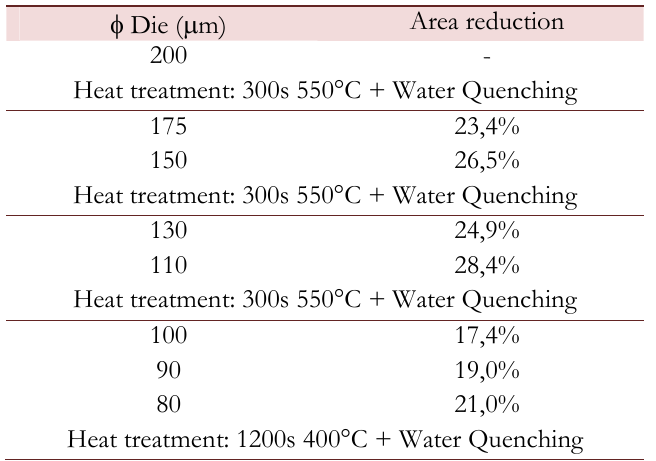
Table 1: Drawing steps and corresponding area reduction.